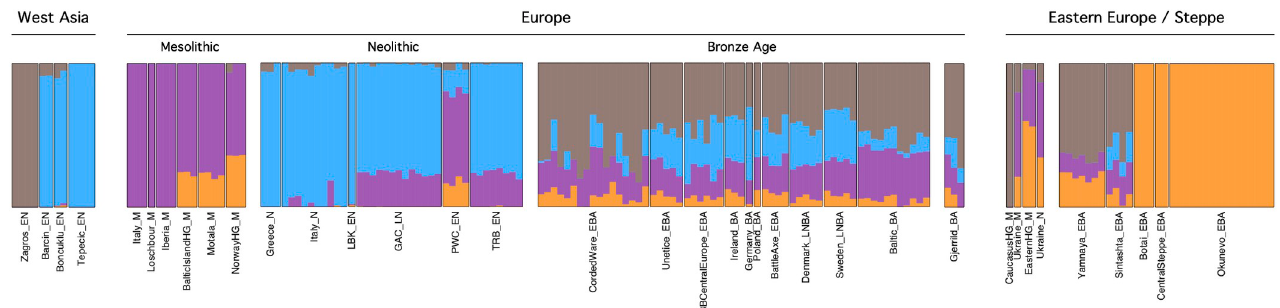
Fig 5. Admixture analysis, selected groups. Barplot of ancestry component proportions inferred using unsupervised ADMIXTURE, for K = 4 components. Gjerrild and other Late Neolithic / Bronze Age European individuals are characterized by a high proportion of a component associated with Steppe pastoralists (brown color, maximized in Iranian Neolithic individuals at this K value), but absent in preceding Neolithic farmer groups. See S3 Table for complete overview of individuals (and references) included in these